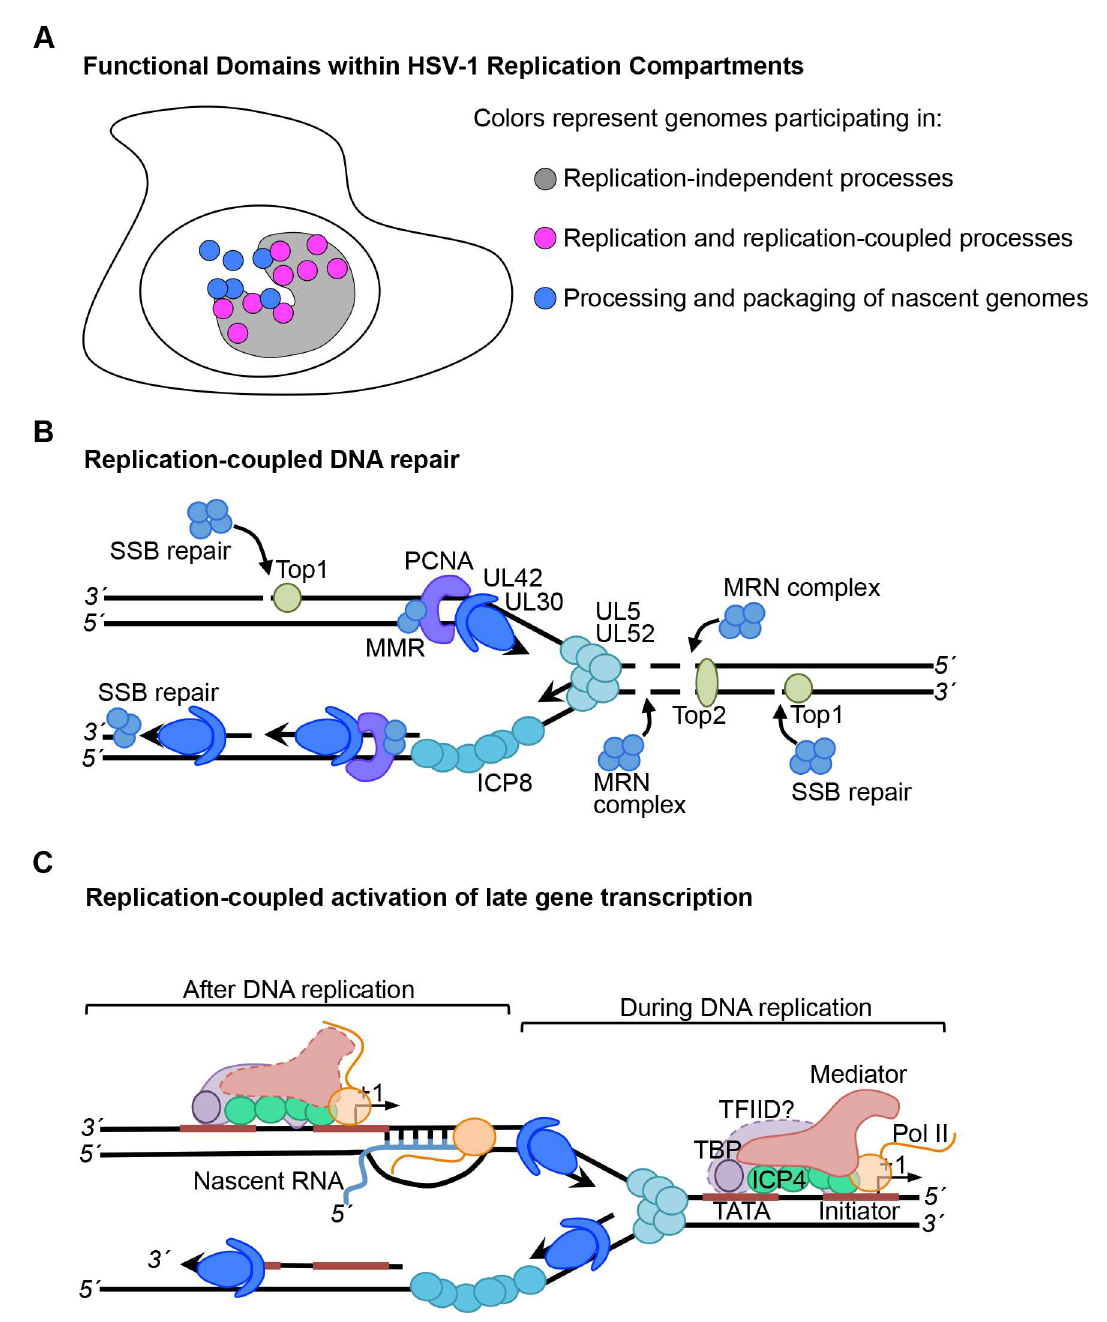
Fig 6. Model Illustrating HSV-1 Replication-Coupled Processes. A. Subdomains within HSV-1 replication compartments containgenomesparticipatingin replication-coupledand replication-independent processes. B. Model depictingreplication-coupled DNA repair and C.